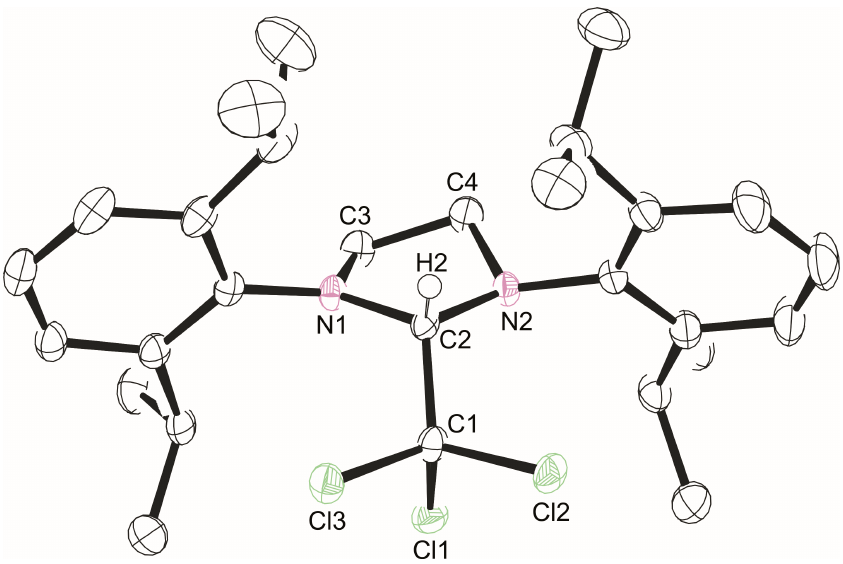
Figure 3. Crystal structure of SIPr(H)CCl 3 . Ellipsoids are shown at the 50% probability level. Hydrogen atoms have been omitted for clarity, with the exception of the proton at the C2 position.